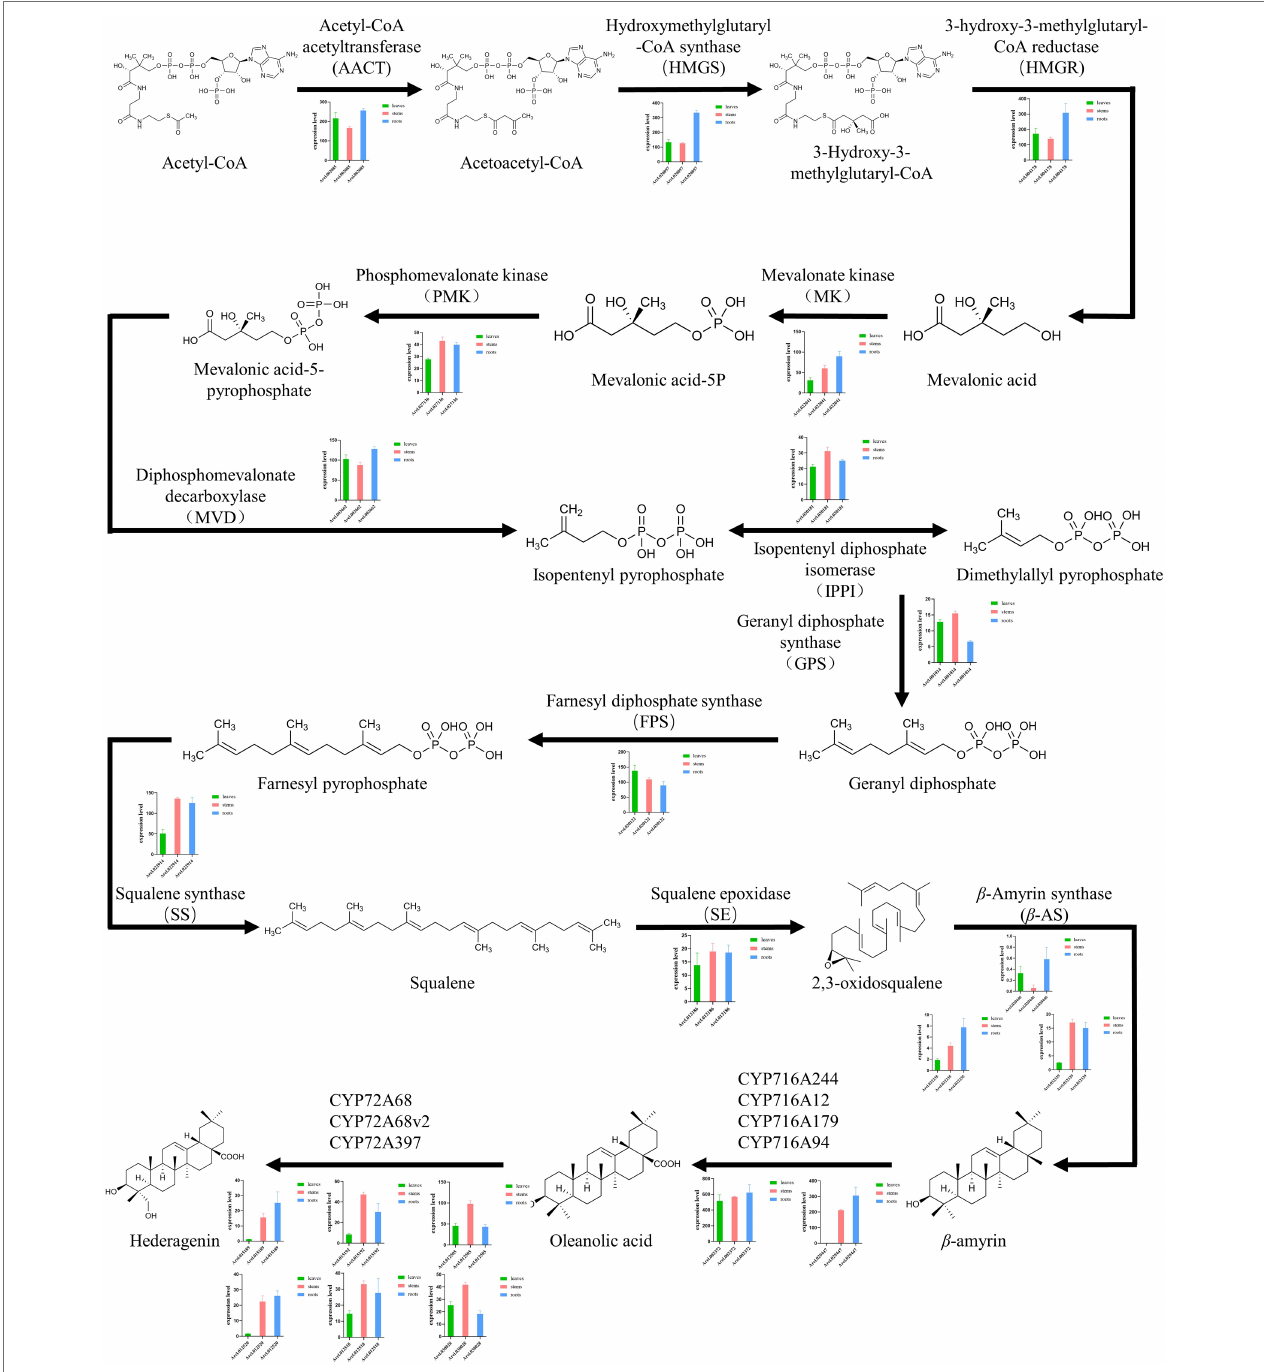
FIGURE 4 | Overview of the saponin biosynthetic pathway in Aralia elata and expression profiles of key enzyme encoding genes. The histogram shows the expression levels of different genes in different tissues. Green indicates the amount of expression in the leaves, red indicates the amount of expression in the stem, and blue indicates the amount of expression in the root. The most genes of enzymes involved in the saponin biosynthesis pathway were highly expressed in roots higher than in leaves and